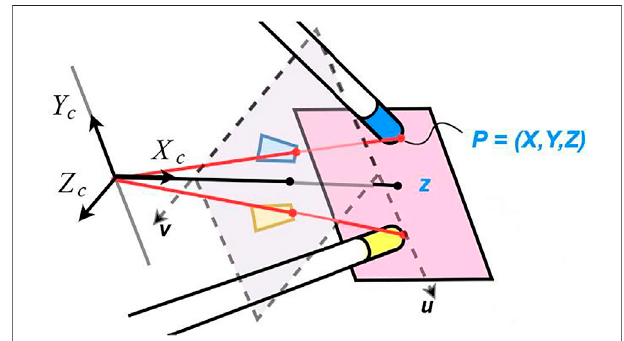
FIGURE 7 | Diagram of the detection process with image